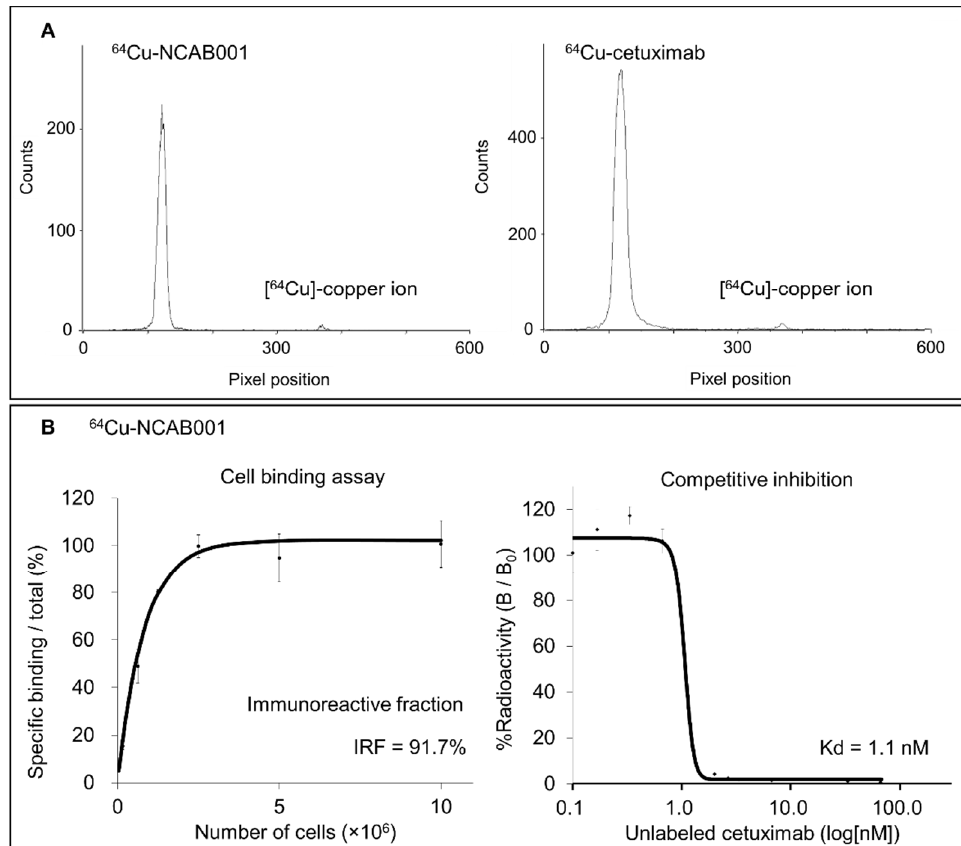
Figure 1. Radiochemical and biological evaluation of 64 Cu-NCAB001. ( A ) Representative thin-layer chromatography (TLC) chromatogram of 64 Cu-NCAB001 and 64 Cu-cetuximab. ( B ) Cell-binding assay of 64 Cu-NCAB001. The immunoreactive fraction (IRF) and the dissociation constant (Kd) of 64 Cu-NCAB001 were determined to be 91.7% and 1.1 nM, respectively.